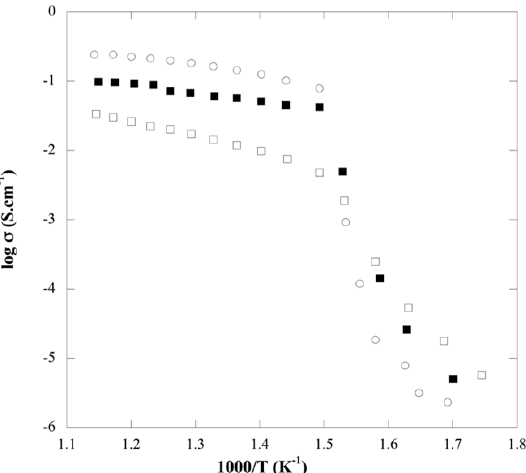
Figure 5. Arrhenius plot of the conductivity of BZY–LKN composites under air (  : BZY–LKN40,